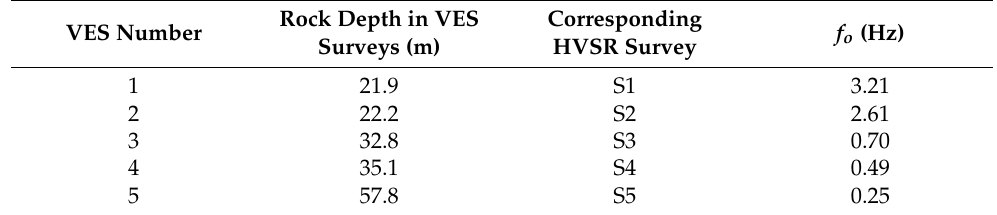
Table 3. Relationship between depth values obtained in VES and corresponding HVSR frequencies.